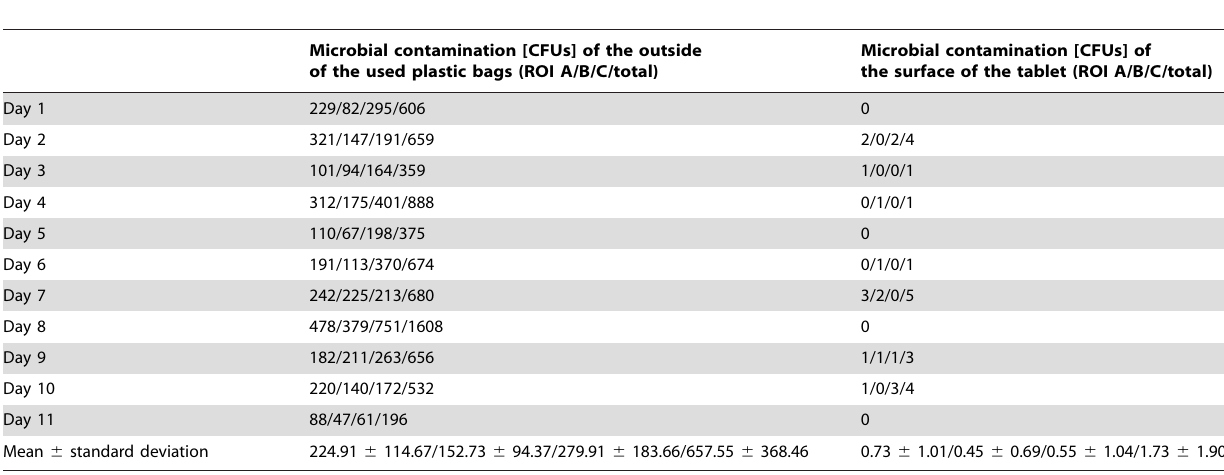
Table 2. Microbial contamination (colony forming units, CFUs) of the outside of the plastic bags (ROI A/B/C/total) and of the surface of the tablet (ROI A/B/C/total) after a one-day usage.